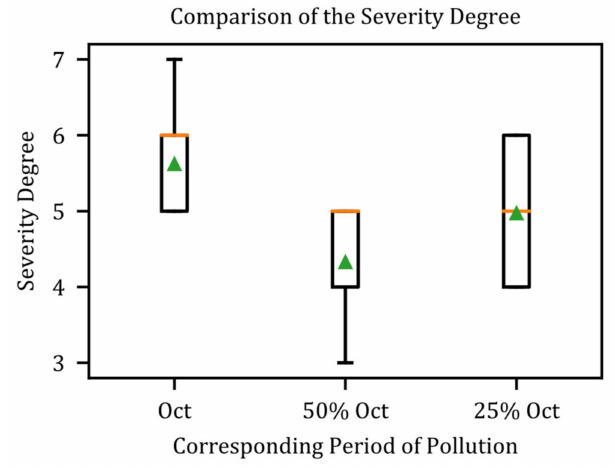
Figure 14. Comparison of the severity degree for three corresponding periods of